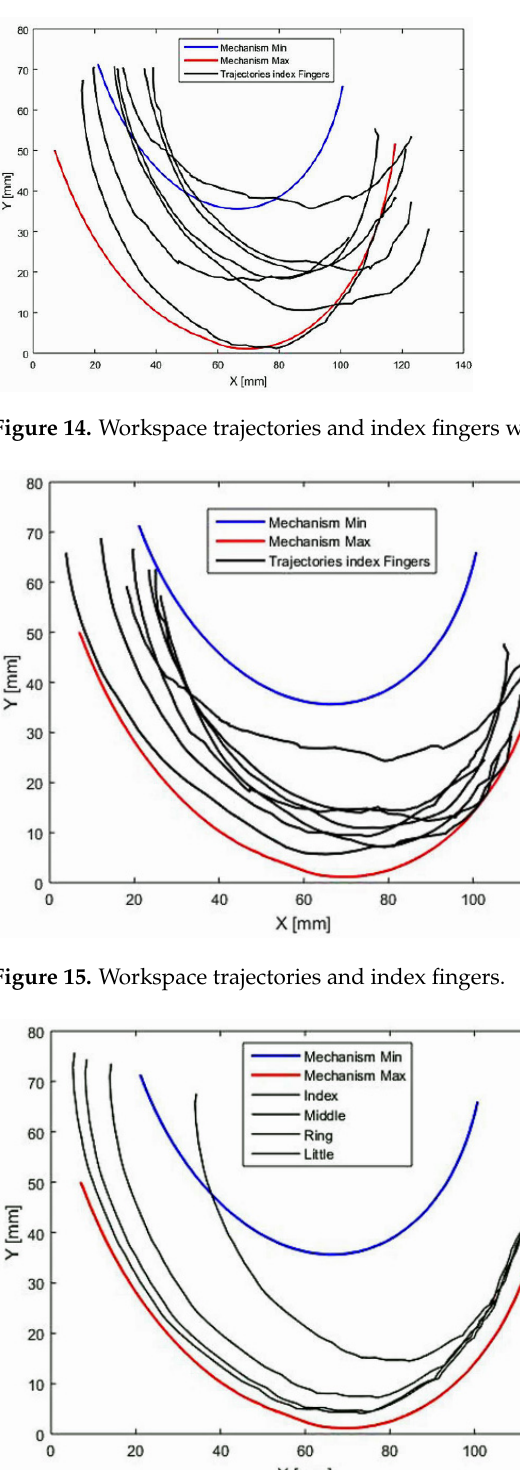
Figure 16. Long fingers hand trajectory validation graph.